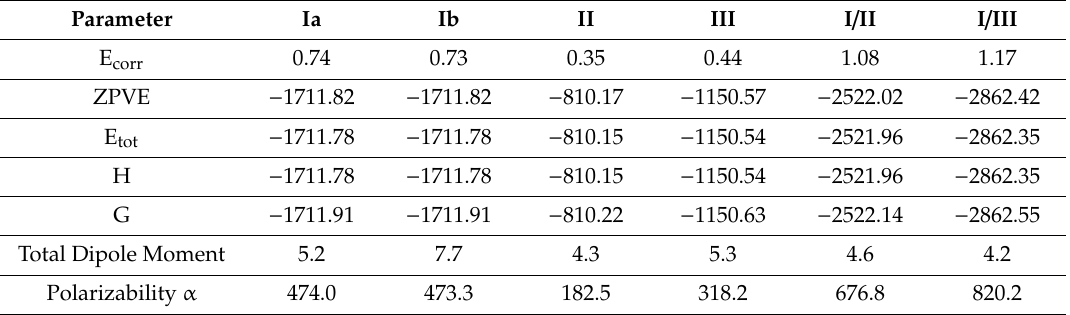
Figure 3. Optimized geometrical structures of the base I (( a ) Ia and ( b ) Ib ), acids ( c ) II and ( d ) III and their supramolecular complex ( e ) I / II and ( f ) I / III ; ( • ) C-atom; ( • ) O-atom; ( • ) N-atom. Table 3. Thermal parameters (Hartree / Particle) and dipole moment (Debye) of the base Ia and Ib, acids II and III and their supramolecular complex I / II and I / III